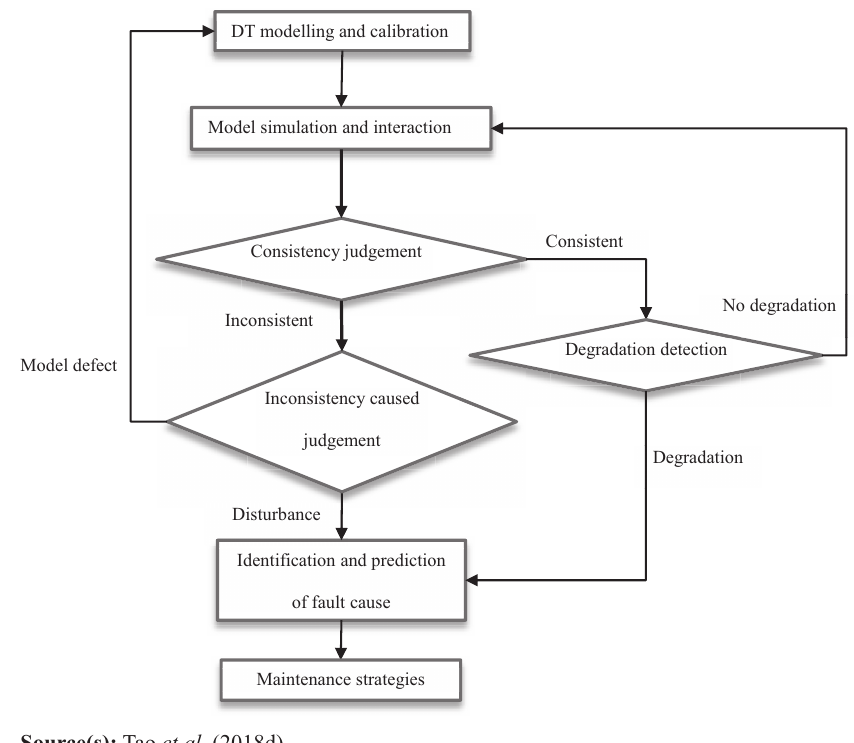
Figure 10. Framework of DT in wind turbine condition